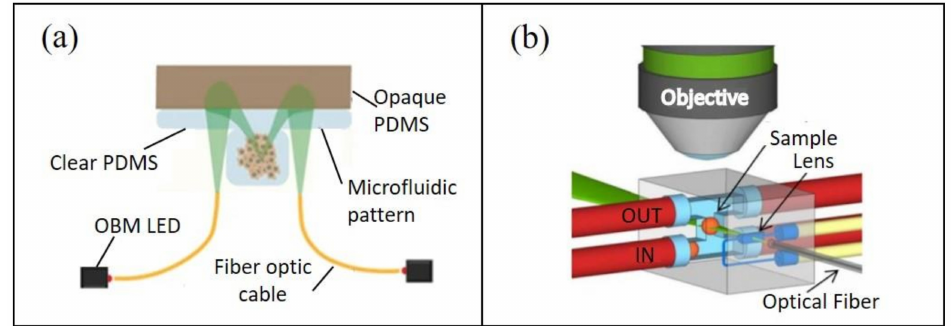
Figure 2. Microfluidic tumor imaging techniques: ( a ) schematic of the oblique back-scattered illumi- nation pathway of the Spheroscope for monitoring microfluidic tumor spheroid growth (adapted from [66]); ( b ) schematic of a device for selective plane illumination microscopy on-chip, using an optofluidic approach (adapted from